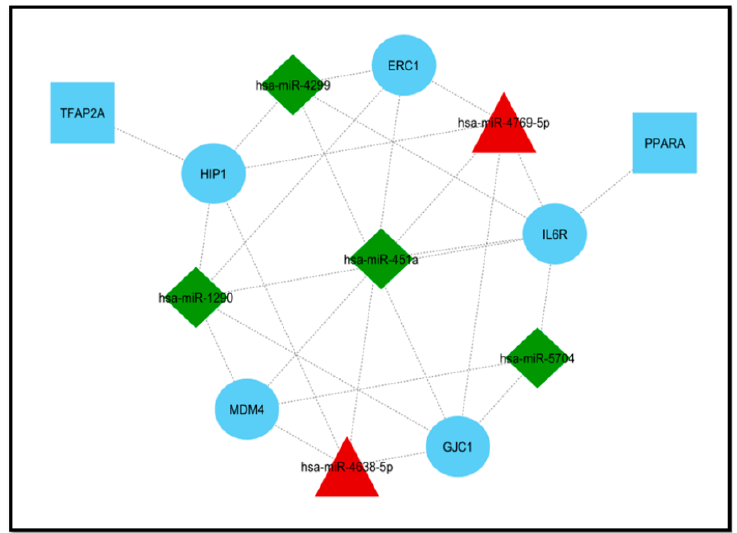
Figure 6. Five hub genes (in blue circles) and their neighbor partner in the main network. Green (diamond) and red (triangle) represent DEMs, and blue (rectangles) represents the transcription factor for the corresponding target hub genes. Transcription factor identification was done from two databases, i.e., TRRUST and